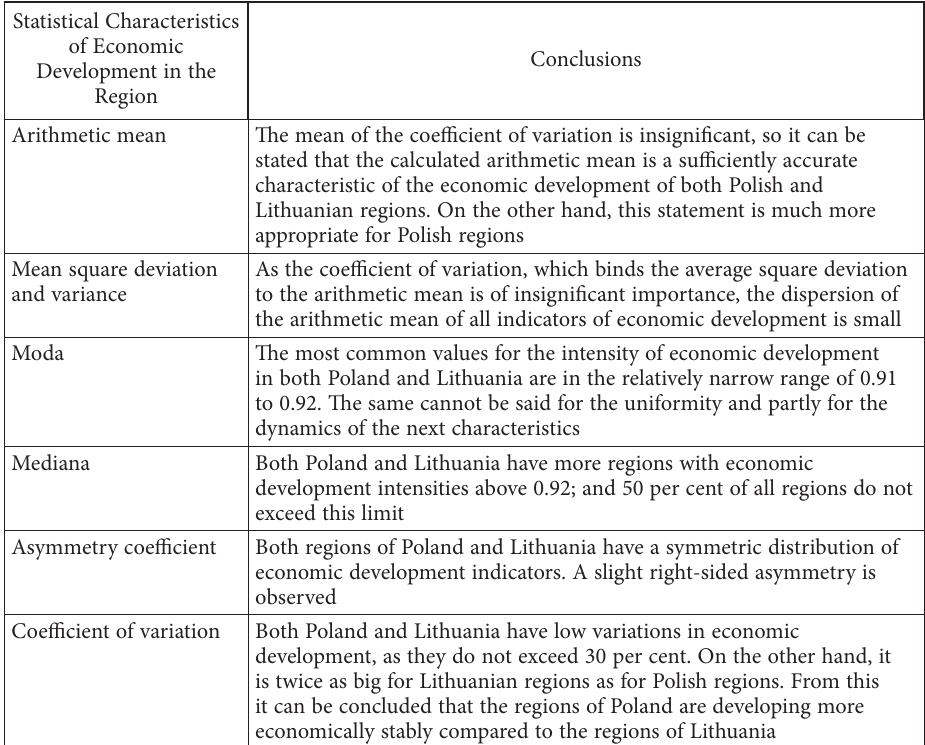
Table 11. Summary of statistical characteristics of Economic Development in Polish and Lithuanian regions 2008–2017 (source: compiled by authors) Statistical Characteristics of